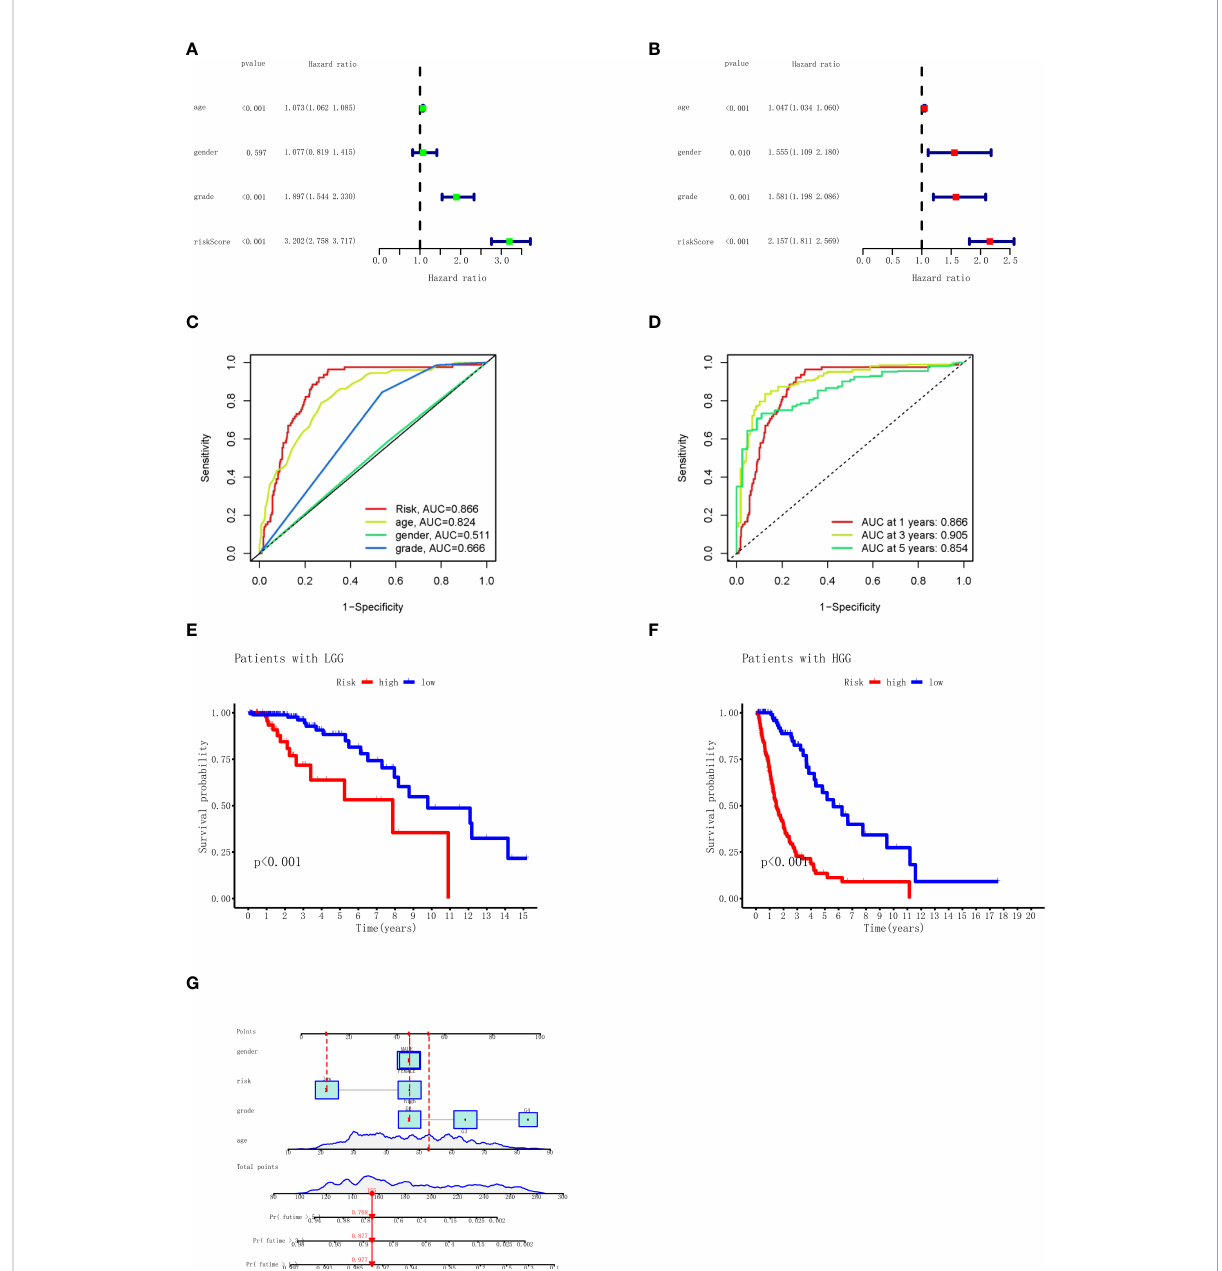
FIGURE 4 Univariate and multivariate Cox regression analyses, Kaplan – Meier survival analysis, and prognostic nomogram model for the risk score. (A) Univariate Cox regression analysis for TCGA (grade: the degree of glioma differentiation, G2 to G4). (B) Multivariate Cox regression analyses for TCGA. (C) AUC in ROC analysis for risk signature age, gender, grade, and risk score in TCGA. (D) AUC in ROC analysis for risk signature at 1-, 3-, and 5-year survival time in TCGA. (E) Kaplan – Meier survival analysis of the LGG high ‐ risk and low ‐ risk groups based on the nine necroptosis-related lncRNAs. (F) Kaplan – Meier survival analysis of the HGG high ‐ risk and low ‐ risk groups based on the nine necroptosis-related lncRNAs. (G) The nomogram prediction for 1-, 3-, and 5-year overall survival probability for glioma patients. TCGA, The Cancer Genome Atlas; AUC, area under the receiver operating characteristic curve; ROC, receiver operating characteristic; LGG, low-grade glioma; HGG, high-grade